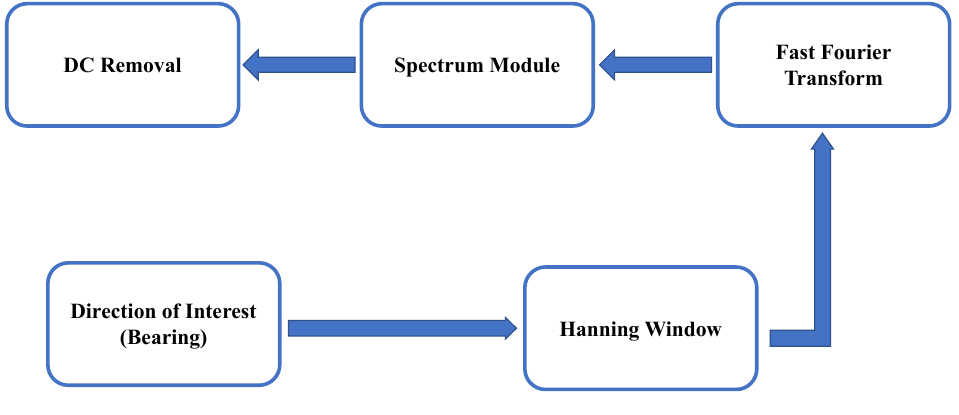
Figure 5. Block diagram of LOFAR Analysis [6].